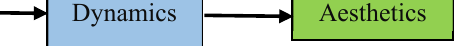
Fig. 1. Enterprise gamification-Two approaches